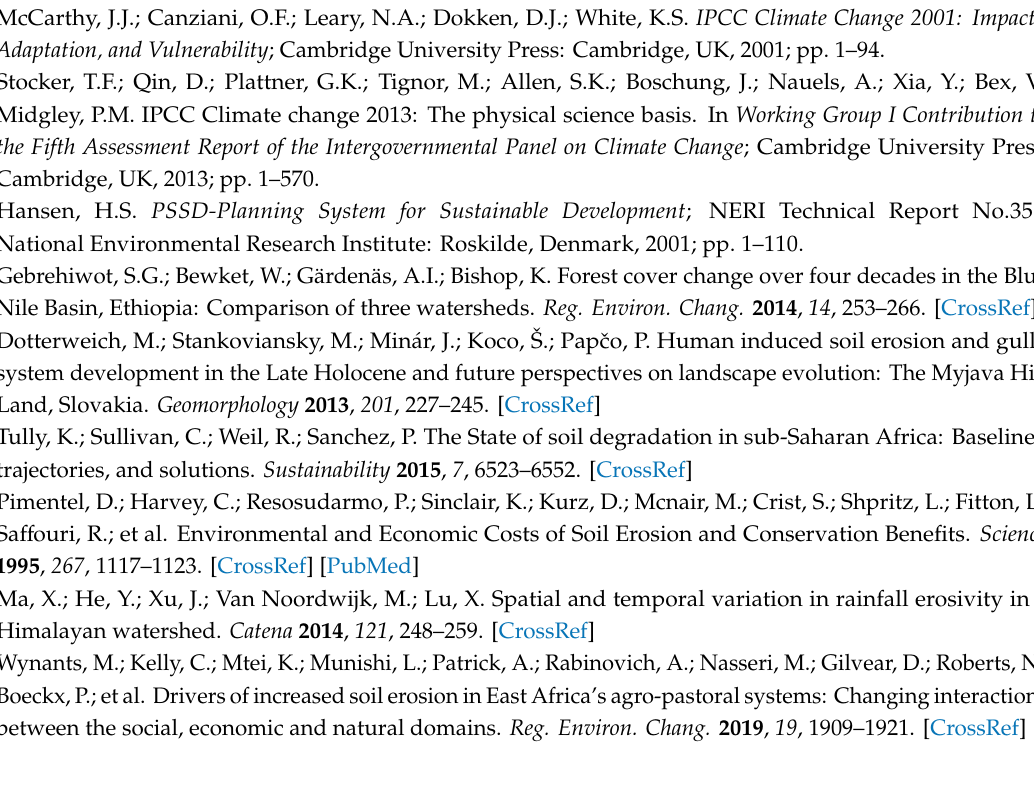
Table S1: Cropping and land-cover (C) factor values used based on previous studies. Table S2: Land Use Land Cover (LULC) classification accuracy and